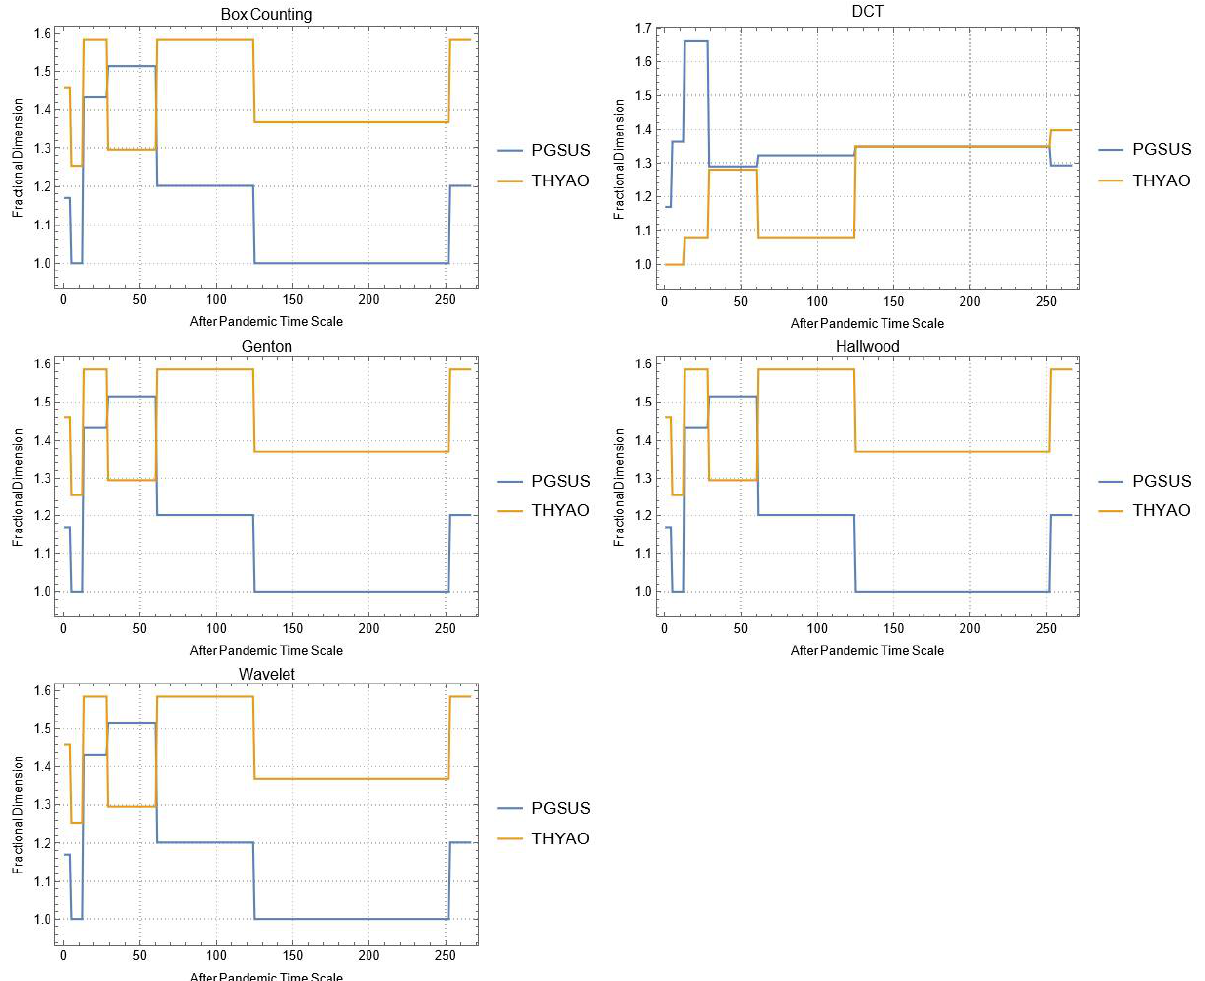
Figure A28. Daily changes of fractal dimensions after the pandemic (transportation).